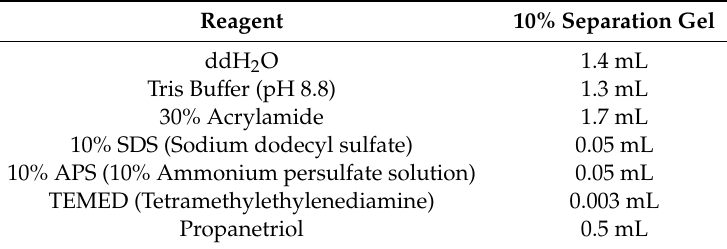
Table 5. SDS-PAGE protein electrophoresis gel